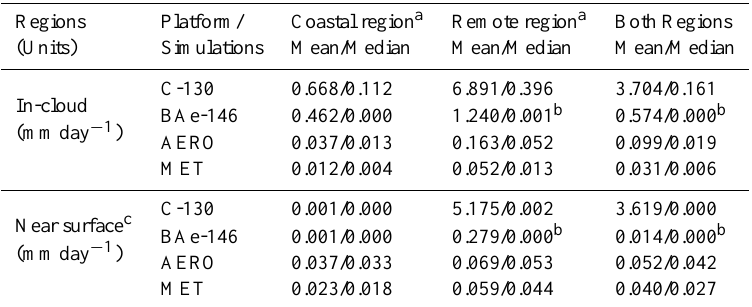
Table 7. Observed and simulated in-cloud and near-surface rain rates.